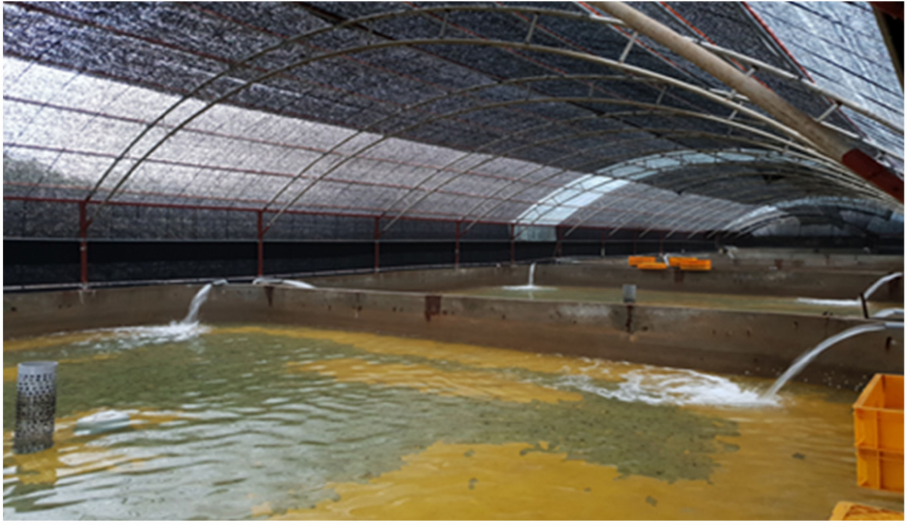
Figure 1. Picture of the flow-through tank systems at a land-based facility used for the current study. To assess growth and maturation, 20 fish (24 h post starvation) were randomly selected from each experimental group at 0, 8, 16, and 20 weeks and euthanized with 100 ppm of 2-phenoxyethanol. Total length (cm), total weight (g), body height (cm), body width (cm), and gonad weight (g) were measured. Tissues samples were dissected from these fish and fixed for histological (gonads) and qPCR (brain, pituitary, liver) analyses, accordingly. The equations used for calculation of growth performance, including weight gain (%), specific growth rate (%/day), condition factor, feed conversion ratio, protein efficiency ratio, feed intake (g), and survival (%) is provided as follows: Weight gain (%) = (FBW − IBW)/IBW × 100 Specific growth rate (%/day) = (Ln(FBW) − Ln(IBW))/days of feeding × 100 Condition factor = FBW/TL 3 × 100 Feed conversion ratio = Dry feed fed/(FBW − IBW) Protein efficiency ratio = (FBW − IBW)/protein given Feed intake = Total dry feed consumed/number of fish Survival (%) = Final fish number/initial fish number × 100 where IBW, FBW, and TL were initial mean body weight (g), final mean body